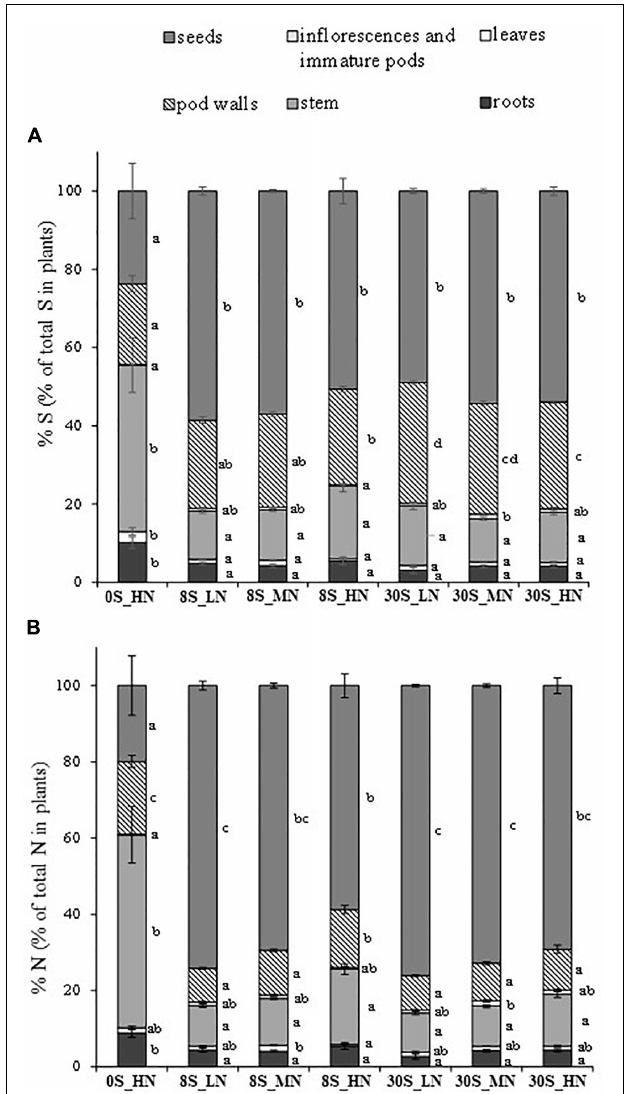
FIGURE 3 | Final S partitioning (%) (A) and final N partitioning (%) (B) for plants grown under 0S_HN, 8S_LN, 8S_MN, 8S_HN, 30S_LN, 30S_MN, and 30S_HN conditions. Vertical bars indicate ± SE of the mean ( n = 5, n = 6 for 8S_LN). Different letters indicate that mean values are significantly different ( p < 0.05) between treatments for the different plant parts.